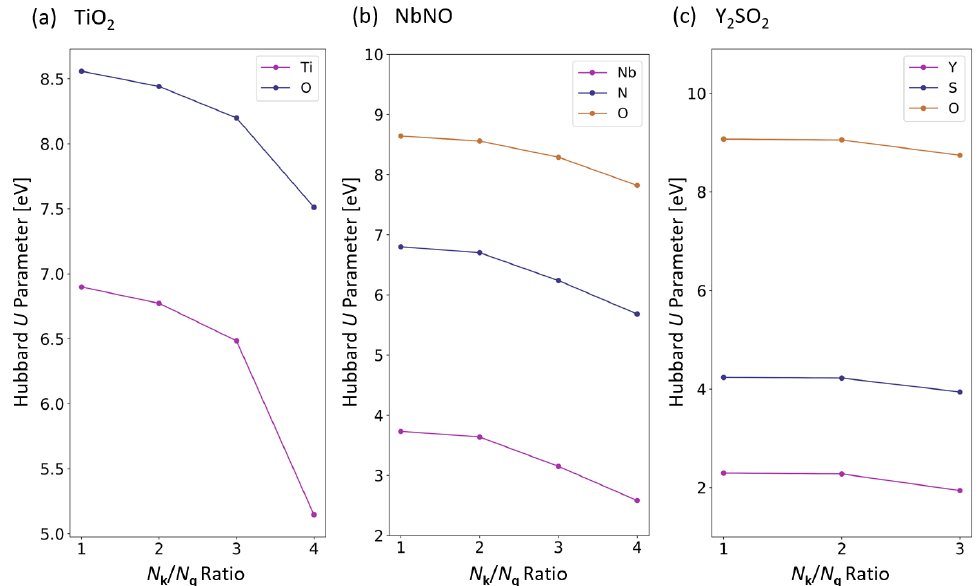
Figure A1. Dependence of the Hubbard U parameter on the N k / N q ratio showing the results of N k / N q testing for 3 representative materials: ( a ) TiO 2 , ( b ) NbNO, and ( c ) Y 2 SO 2 . For each plot, the q points density increases from right to left, where at N k / N q =1, the q -point mesh matches the k -point mesh. In panel ( c ), Y 2 SO 2 does not have a N k / N q ratio of 4 plotted because its N k / N q ratio of 3 results in a q mesh equivalent to that produced using a N k / N q ratio of 4 (see Table A1).